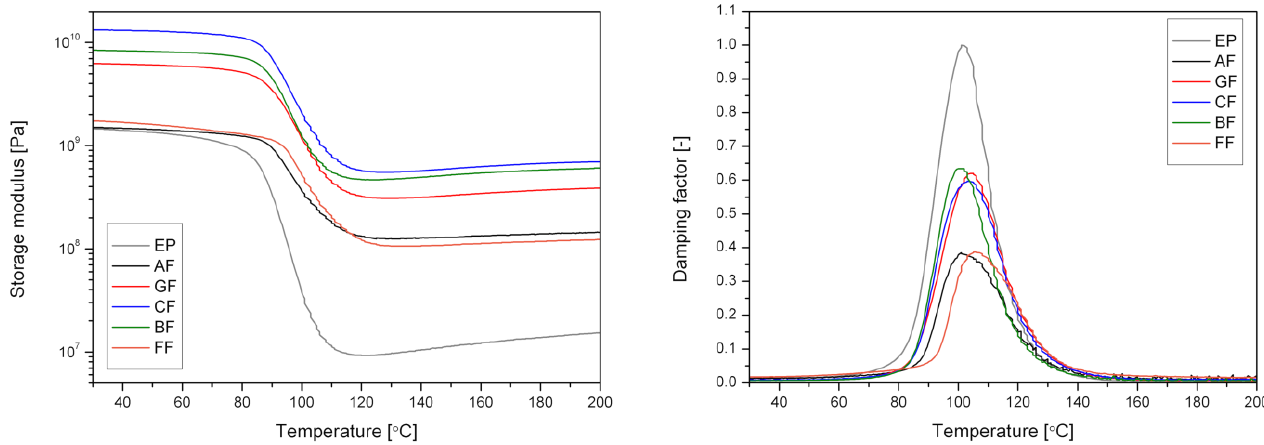
Figure 12. Storage modulus and damping factor vs. temperature curves of EP and EP laminates made using various fibers obtained by dynamic mechanical–thermal analysis (DMTA).